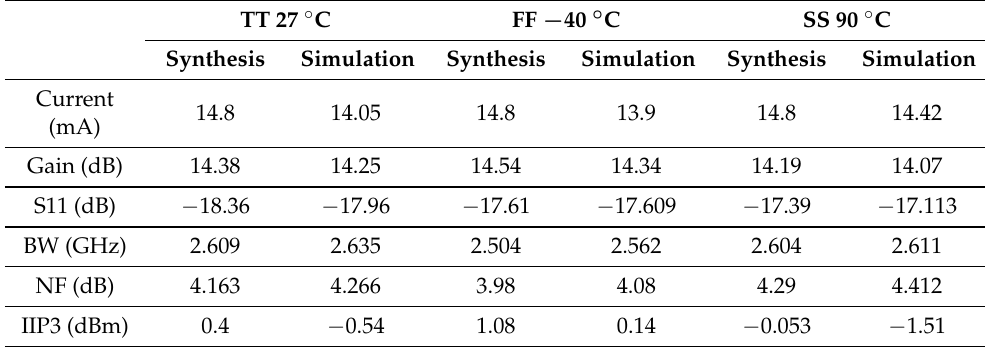
Table 6. Comparison of the achieved specifications from the proposed synthesis flow vs. spectre simulation results for the second design example.